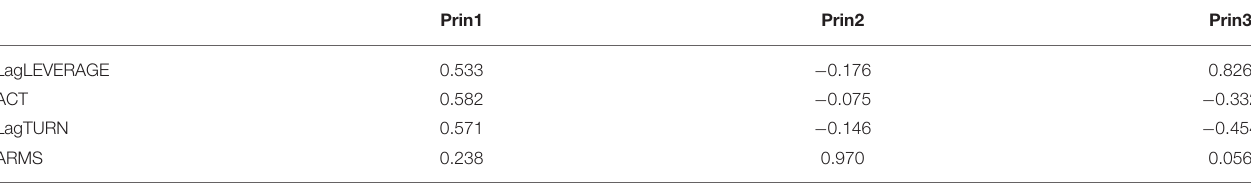
TABLE 3 | Factor loading of the first three principal components.